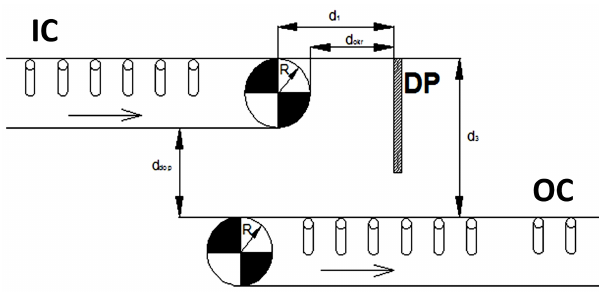
Figure 1. Simplified model of material re-direction. DP – damping plate; IC – incoming conveyor; OC – outgoing conveyor.